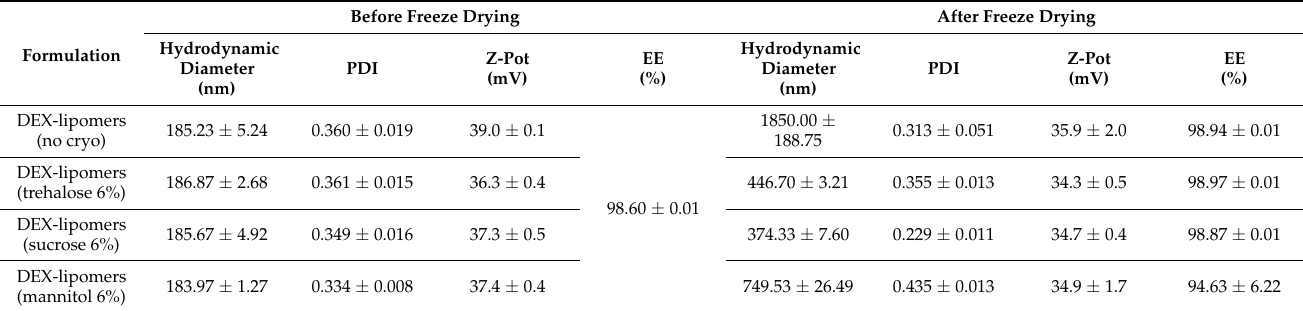
Table 4. Particle size, polydispersion (PDI), zeta potential, and encapsulation efficiency (EE) of nanoparticles before and after lyophilization with different